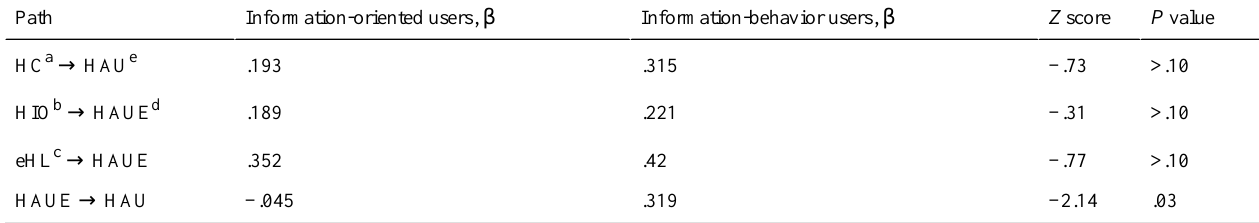
Table 2. Comparisons of regression coefficients between information-oriented users and information-behavior users.